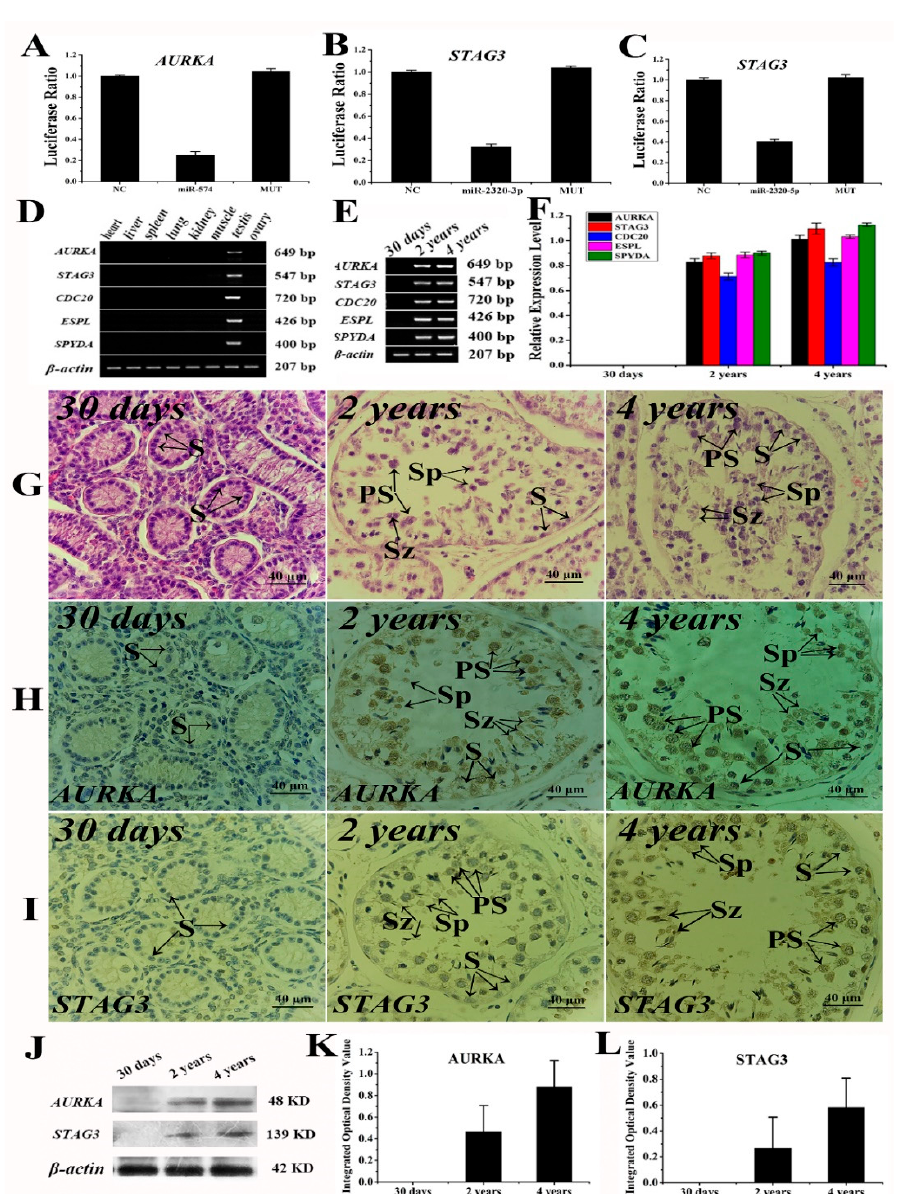
Figure 6. The crucial role of AURKA of yak testis in development and gametogenesis. ( A ) Validating AURKA as a target of miR-574 using a dual luciferase reporter assay. ( B , C ) Validating STAG3 as a target of miR-21-3p and miR-2320-3p using a dual luciferase reporter assay. ( D ) The crucial DEGs of oocyte meiosis were chosen for evaluating the role of AURKA in different tissues by RT-PCR. ( E ) The crucial DEGs were detected in testis samples of different development stages by RT-PCR. ( F ) The relative expression level of these DEGs was gradually upregulated with testis development. ( G ) H&E staining of testis samples at different developmental stages. ( H , I ) Immunohistochemical stain assay for expression and location of AURKA and STAG3 in testis samples in the different development stages. ( J ) Western blot assay for detecting the expression level of AURKA and STAG3 in testis samples in different developmental stages. ( K , L ) Relative protein expression level of AURKA and STAG3.